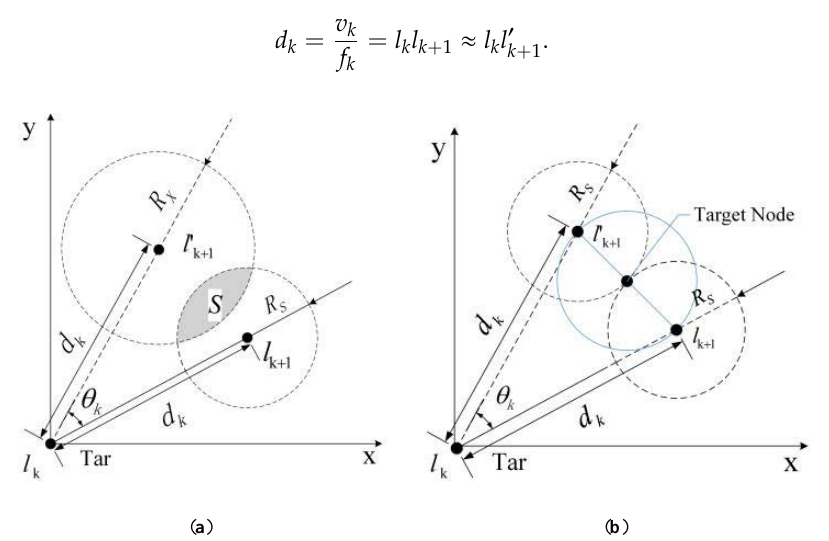
Figure 3. Target maneuver model. ( a ) Target maneuver model in general; ( b ) Target maneuver model under extreme